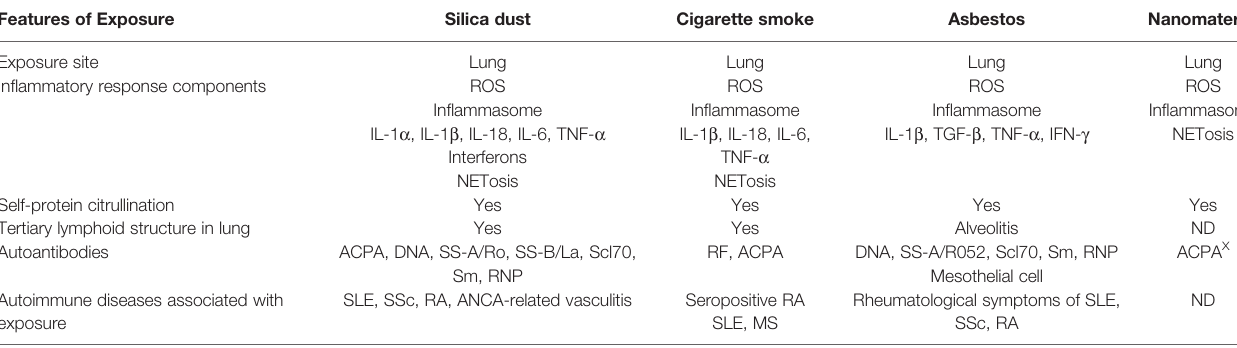
TABLE 1 | Comparison of hypothesized steps leading to autoimmune disease following exposure to inhaled materials. Features of